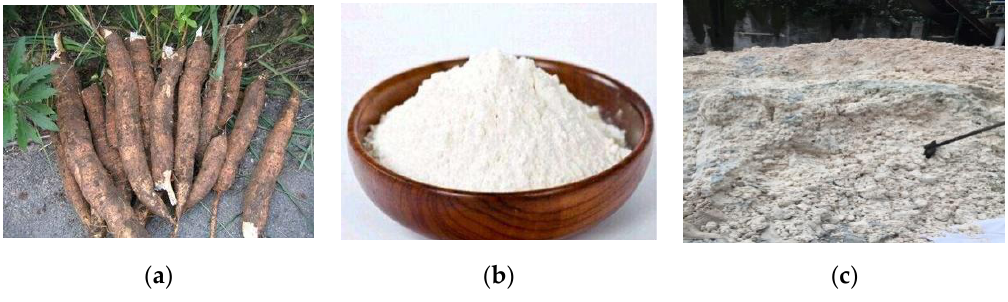
Figure 1. Photographs of ( a ) cassava, ( b ) cassava starch, and ( c ) cassava